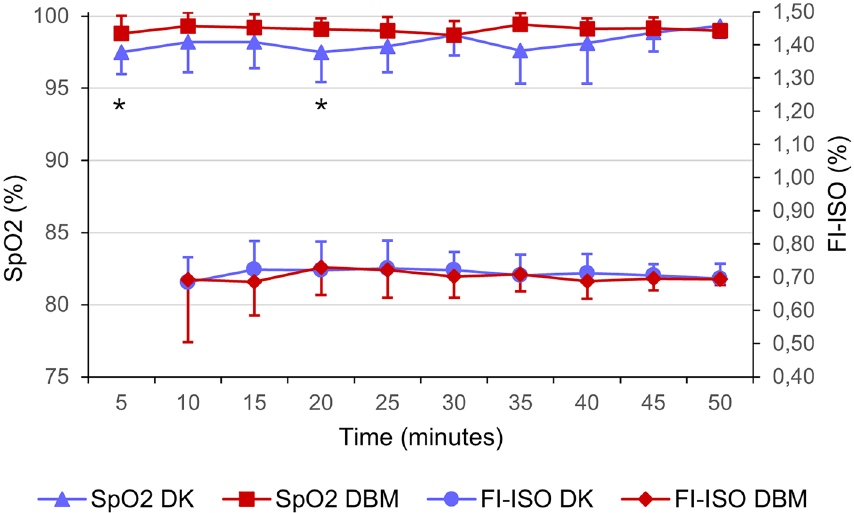
Figure 3. Peripheral oxygen saturation (SpO 2 ) and fraction of inspired isoflurane (FI-ISO) in 20 Egyptian fruit bats during general anaesthesia for gonadectomy. Bats in group DK (n = 10) received DEX and KET combination and bats in group DBM (n = 10) received DEX, BUT and MDZ administration. Results are presented as mean ± standard deviation. Significant differences at specific time points ( p < 0.05) in SpO 2 were found (represented as asterisk).